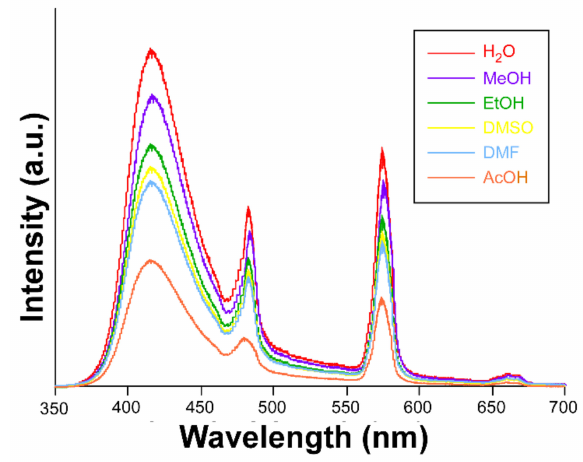
Figure 6. The emission spectrum of compound 2 . Inset: color coding.